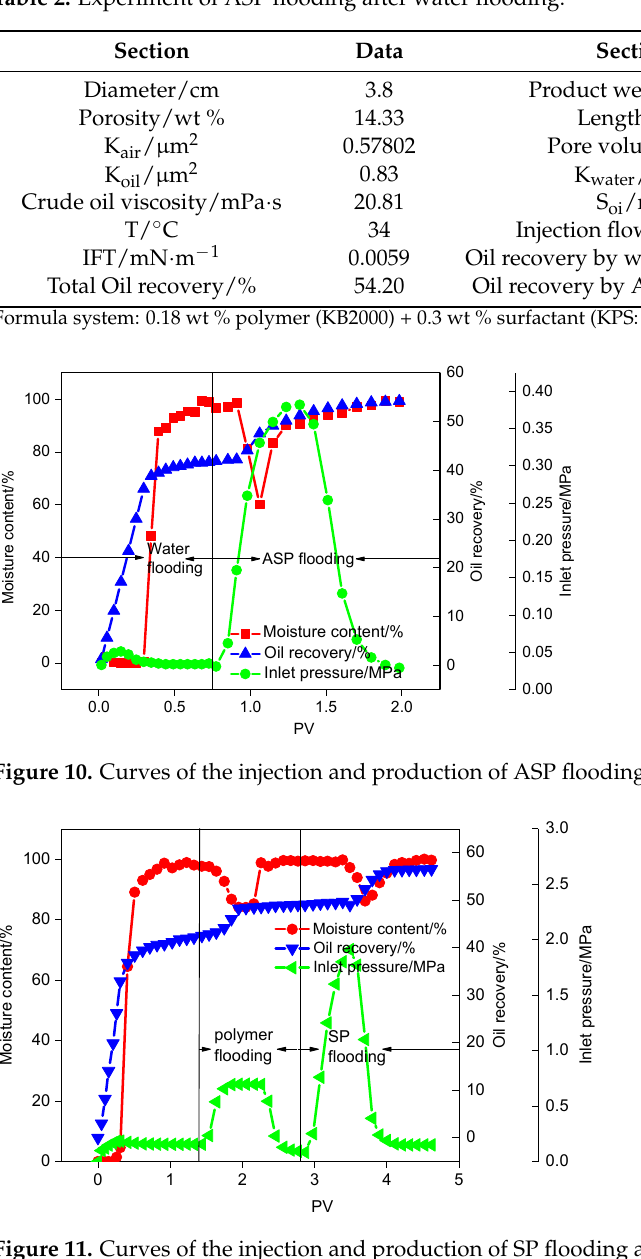
Figure 11. Curves of the injection and production of SP flooding after polymer flooding.